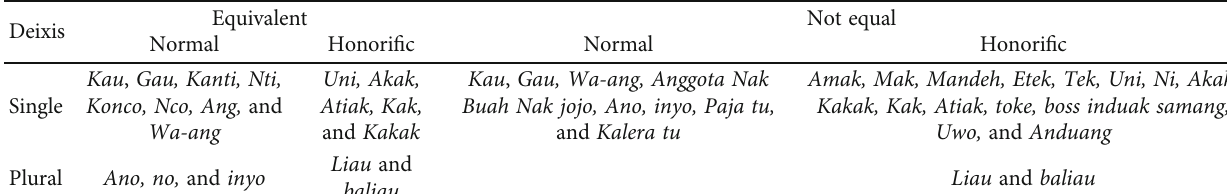
Table 4: Deixis of the second-person female pronouns in Pasar Bawah Bukittinggi.